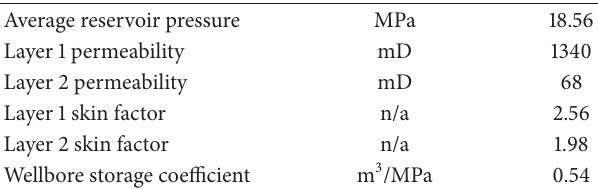
Table 8: Interpretation results of Field Test Two (Well